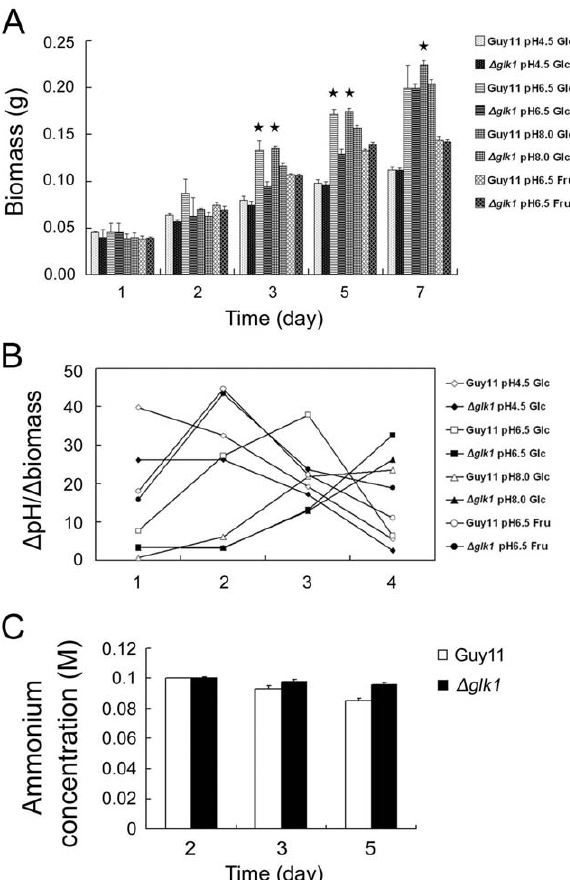
Figure 3. The D Moglk1 mutants show decreased ammonium utilization in the presence of glucose as sole carbon source. (A) The dry weight of mycelia from Guy11 and D Moglk1 strains grown in 100 mM ammonium-containing MM liquid culture with 1% glucose or 1% fructose as sole carbon source in indicated pH. Error bars indicate standard deviations from the mean. P values were calculated comparing Guy11 with D Moglk1 mutant mycelia dry weight. * indicates P , 0.05. (B) The relationship between the drop in extracellular pH and the increase of fungus biomass. X-axis represents the time interval. 1, between 2nd and 1st day; 2, between 3rd and 2nd day; 3, between 5th and 3rd day; 4, between 7th and 5th day. The Y-axis represents the ratio of pH and biomass. pH indicates the drop of pH between the interval days (data from fig. 2A); biomass indicates the increase of biomass between the interval day (data from fig. 3A). (C) The medium (MM + 1% glucose) ammonium concentration after incubation of Guy11 and D Moglk1 mutant for indicated days. The initial concentration of ammonium in the medium was 100 mM. Error bars indicate standard deviations from the mean. The experiment was repeated three times with similar results.